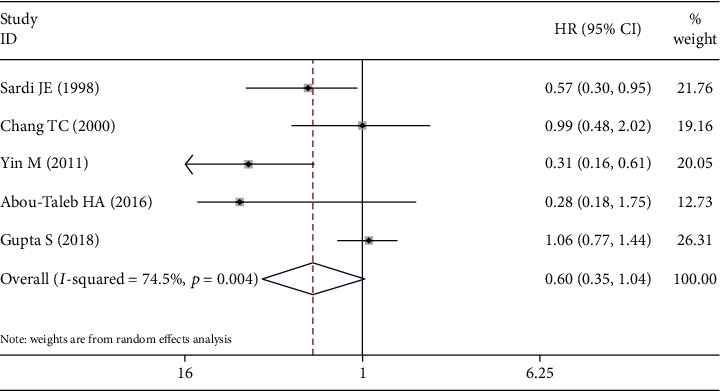
Forest plots for the overall survival.